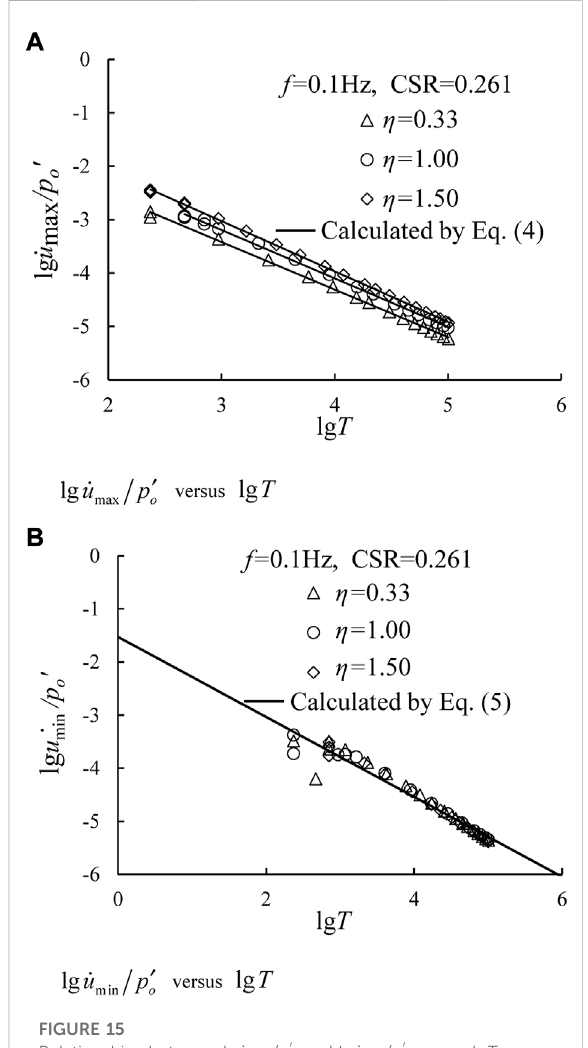
FIGURE 15 Relationships between lg _ u max / p ′ o and lg _ u min / p ′ o versus lg T based on test results from Gu (2012). (A) lg _ u max / p ′ o versus lg T and (B) lg _ u min / p ′ o versus lg T